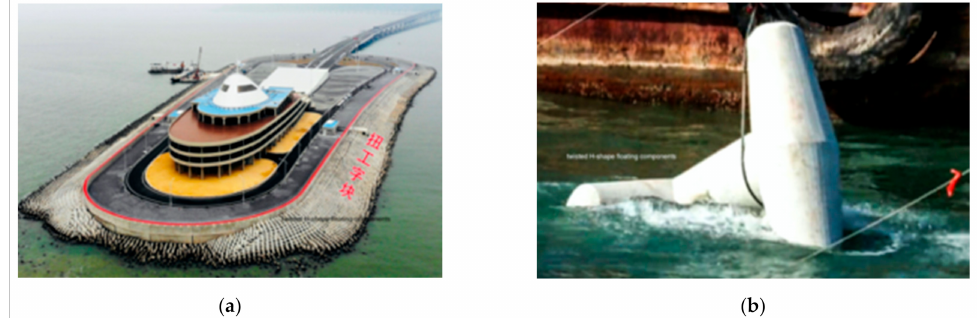
Figure 17. ( a ) Photo of the man-made island; ( b ) the twisted H-shape concrete constructs. (Photos from online